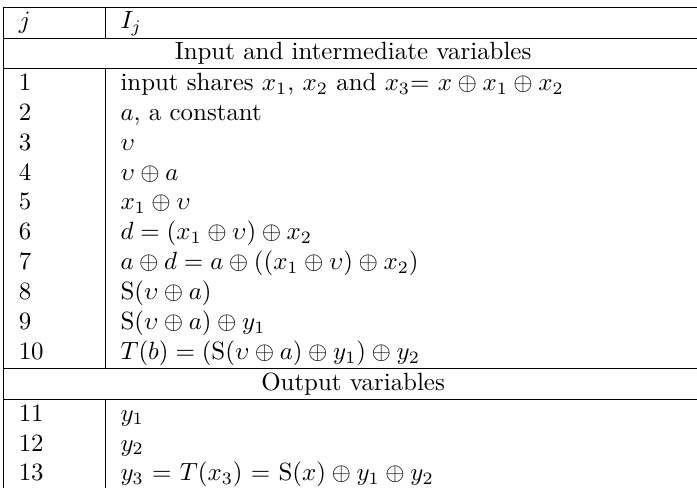
Table 1 into two sets : Set 1 := input and intermediate variables , Set 2 := output shares